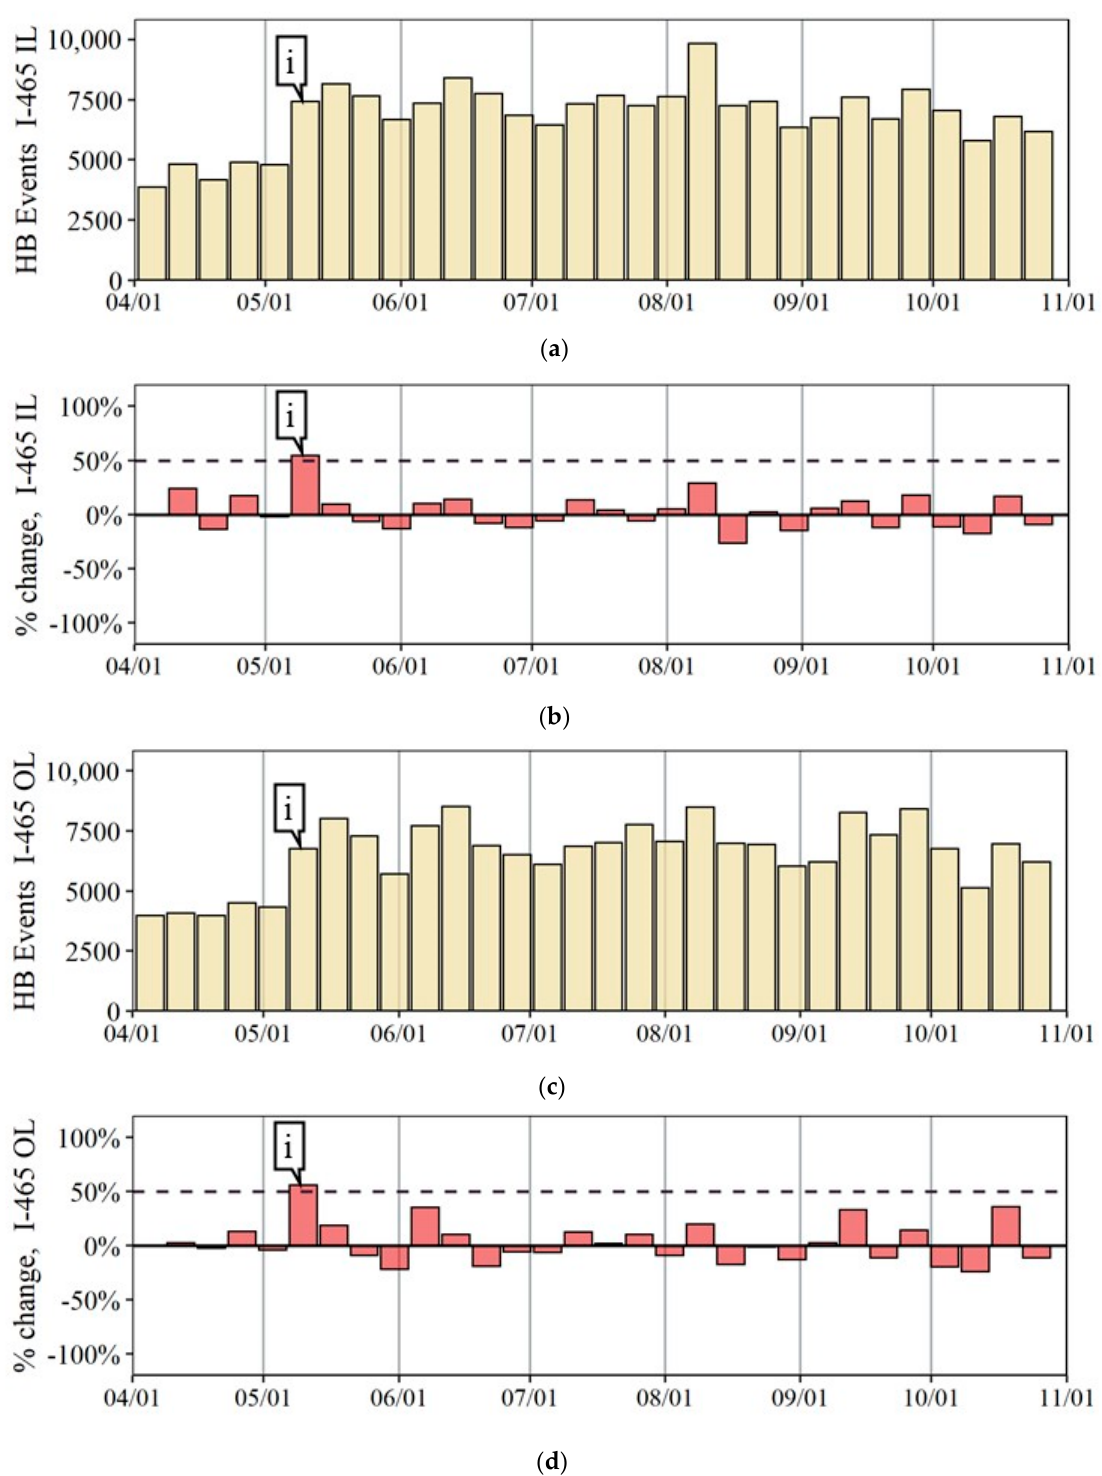
Figure 6. Comparison of hard-braking events across I-465. ( a ) Weekly hard-braking events (Inner Loop); ( b ) Percentage change in hard-braking events from previous week (Inner Loop); ( c ) Weekly hard-braking events (Outer Loop); ( d ) Percentage change in hard-braking events from previous week (Outer Loop).